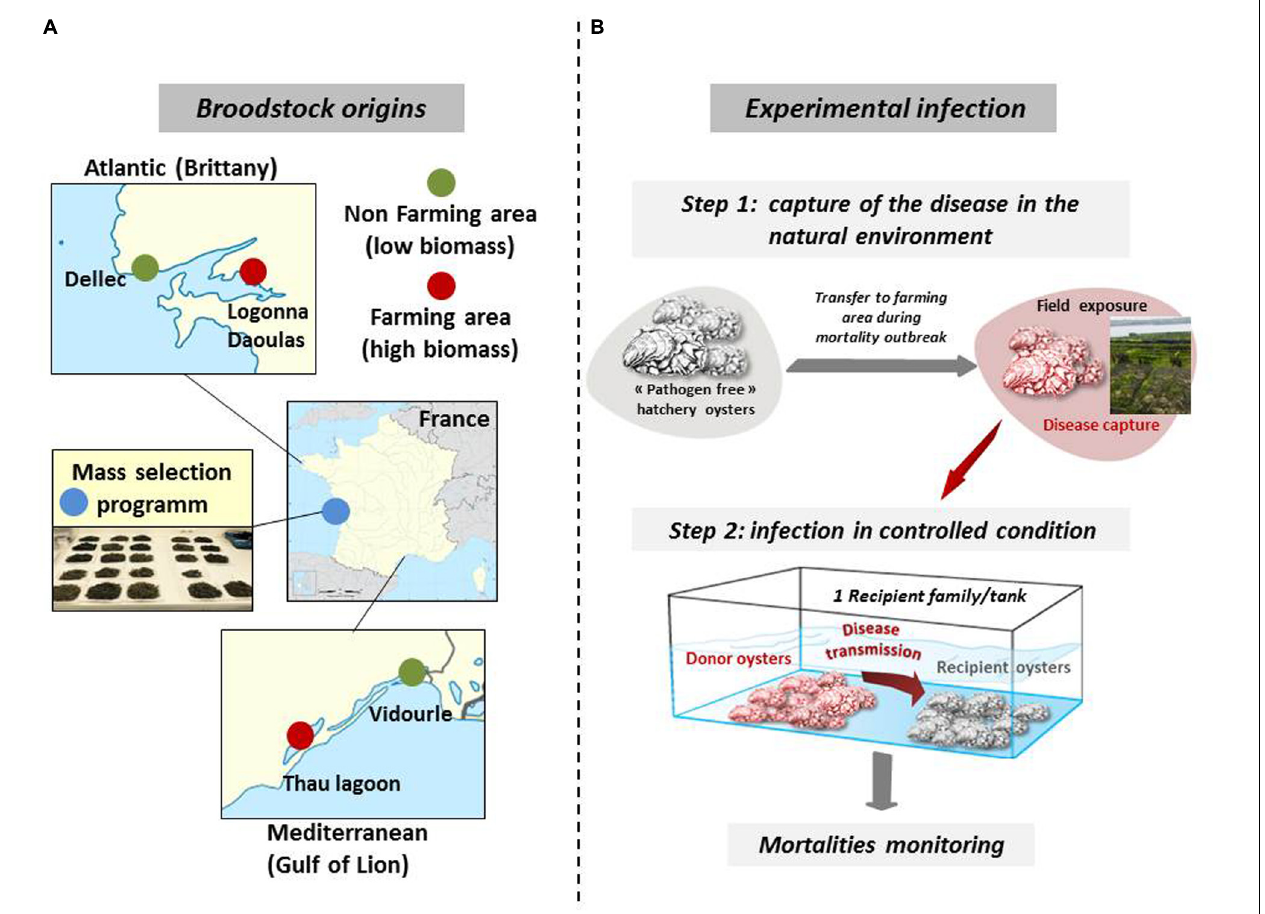
FIGURE 1 | Broodstock origins for the production of biparental oyster families and schematic of experimental infection. (A) Wild stocks were sampled in farming (red) and non-farming (green) sites in two geographic areas (Atlantic and Mediterranean coasts). Mass selected oysters (blue) originated from the Ifremer hatchery of La Tremblade. Image source: commons.wikimedia.org. (B) For experimental infection, pathogen free oysters were deployed in the natural environment in a farming area during disease outbreaks and brought back to a controlled environment to transfer the disease to each oyster families under controlled conditions.